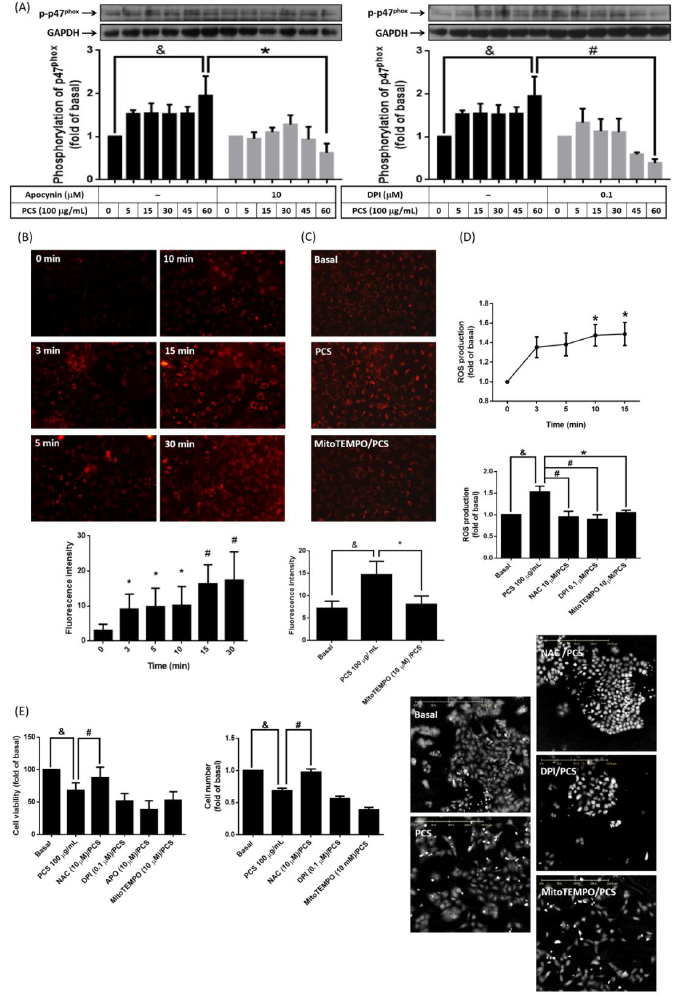
Figure 3. Intracellular reactive oxygen species (ROS) involve in PCS-induced human pulmonary alveolar cell death. ( A ) Cells were treated without or with apocynin (APO, 10 µ M) or diphenylene iodonium (DPI, 0.1 µ M) for 1 h, and then incubated with 100 µ g/mL PCS for the indicated time points. Phosphorylation of p47 phox protein (NADPH oxidase subunit) was determined by Western